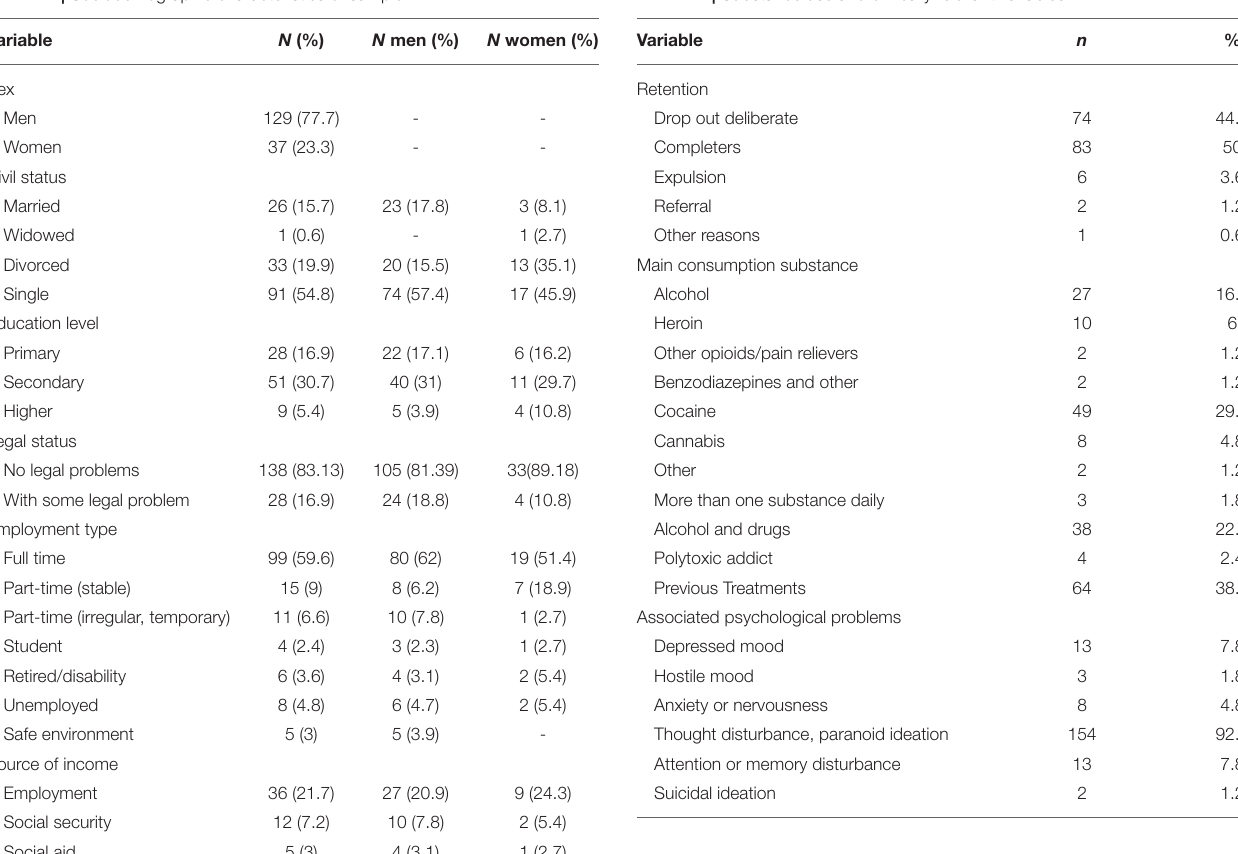
TABLE 1 | Sociodemographic characteristics of sample. TABLE 2 | Substance use and clinically relevant